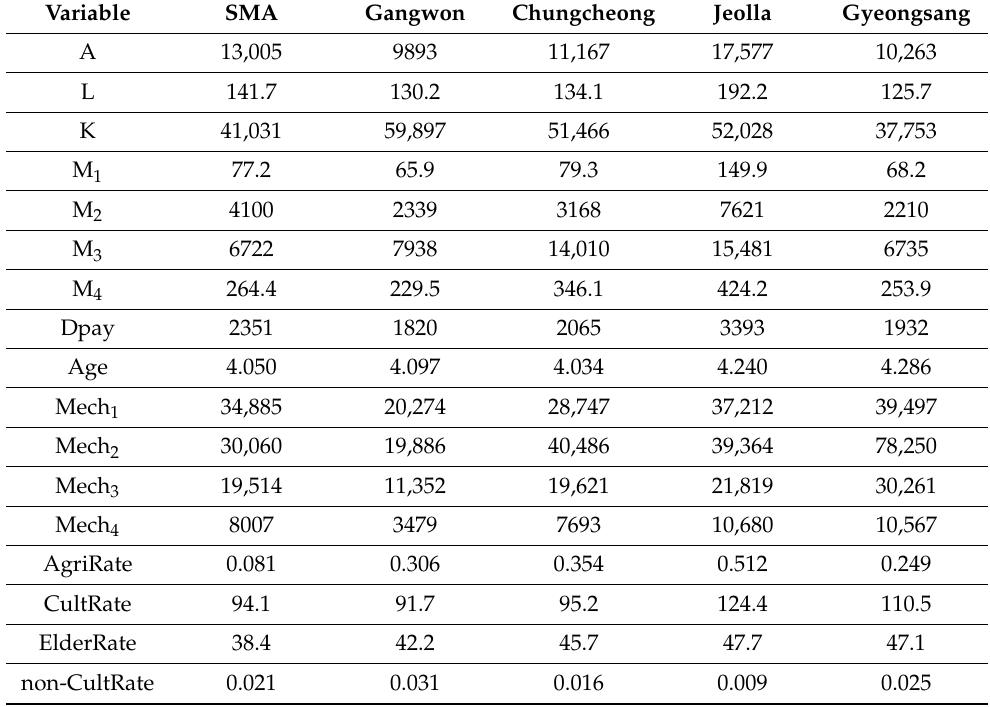
Table 7. Average estimators in agricultural output and costs by region in